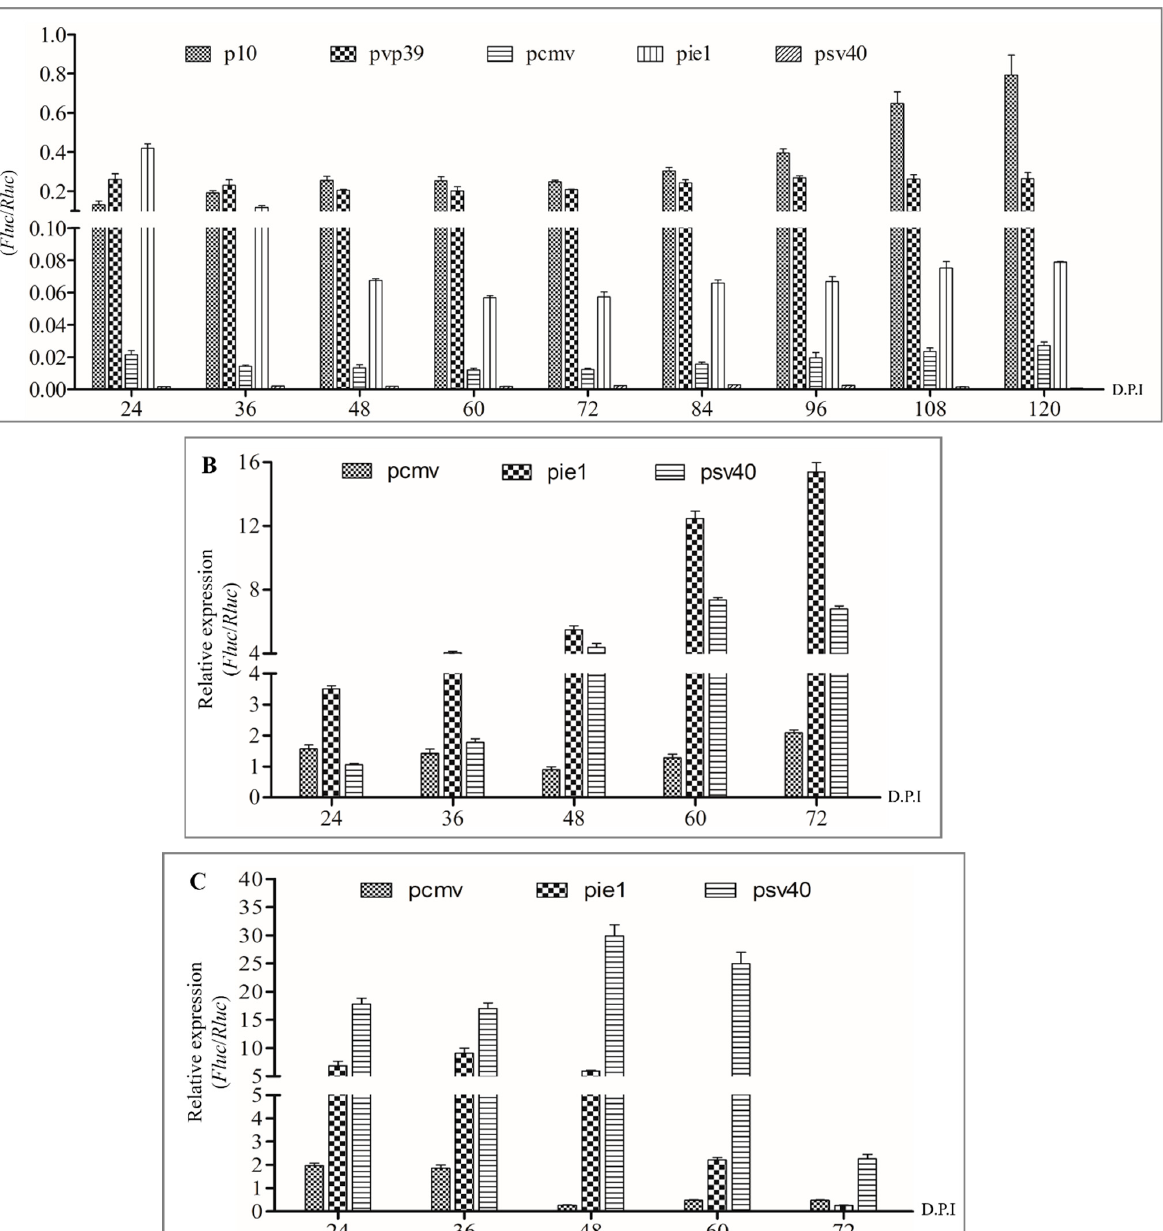
Figure 5. Determination of promoter expression in Sf9 and mammalian cells. ( A ) Promoters mediate the relative expression of Firefly luciferase ( Fluc ) compared with Renilla luciferase ( Rluc ) in Sf9 cells ( Fluc / Rluc ). ( B ) Mammalian promoters mediate the relative expression of Fluc / Rluc in 293T cells. ( C ) Mammalian promoters mediate the expression of Fluc / Rluc in BHK-21 cells.